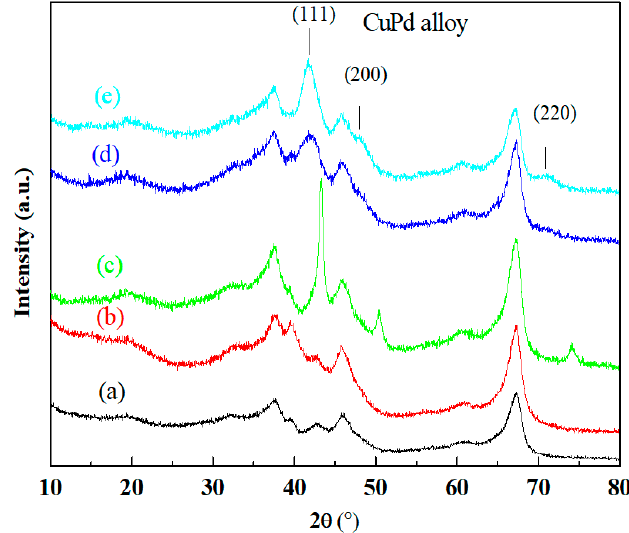
Figure 3. X-ray diffraction patterns of the reduced catalysts ( a ) γ -Al 2 O 3 ; ( b ) Pd/ γ -Al 2 O 3 ; ( c ) Cu/ γ -Al 2 O 3 ; ( d ) Cu-Pd/ γ -Al 2 O 3 ; ( e ) Cu-Pd/(Mg) γ -Al 2 O 3. ( c ) Cu/ γ -Al γ -Al γ -Al 2 O 3 ; ( d ) Cu-Pd/ 2 O 3 ; ( e ) Cu-Pd/(Mg) 2 O